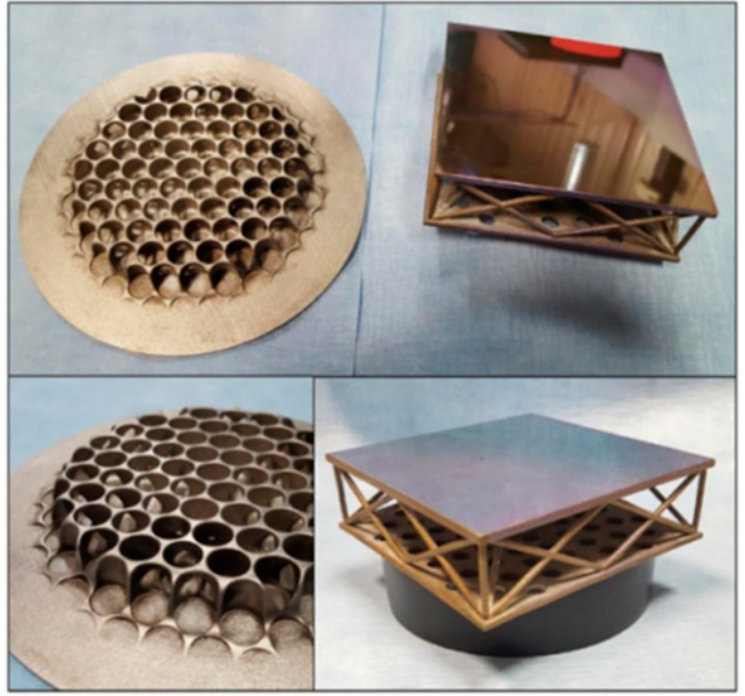
Figure 15. Round and square metal mirrors [32].